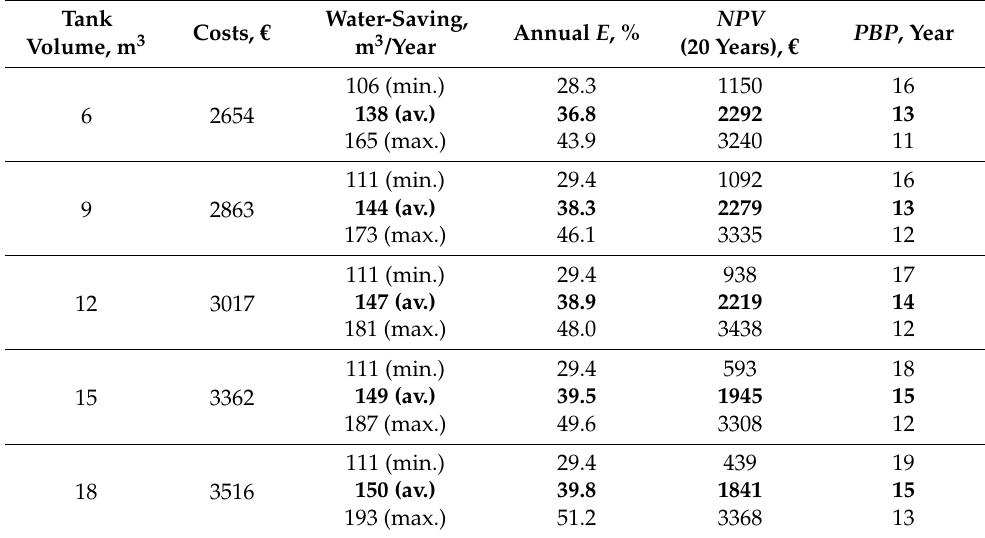
Table 1. Net present value ( NPV ) and payback period ( PBP ) values related to each tank size for the RWH